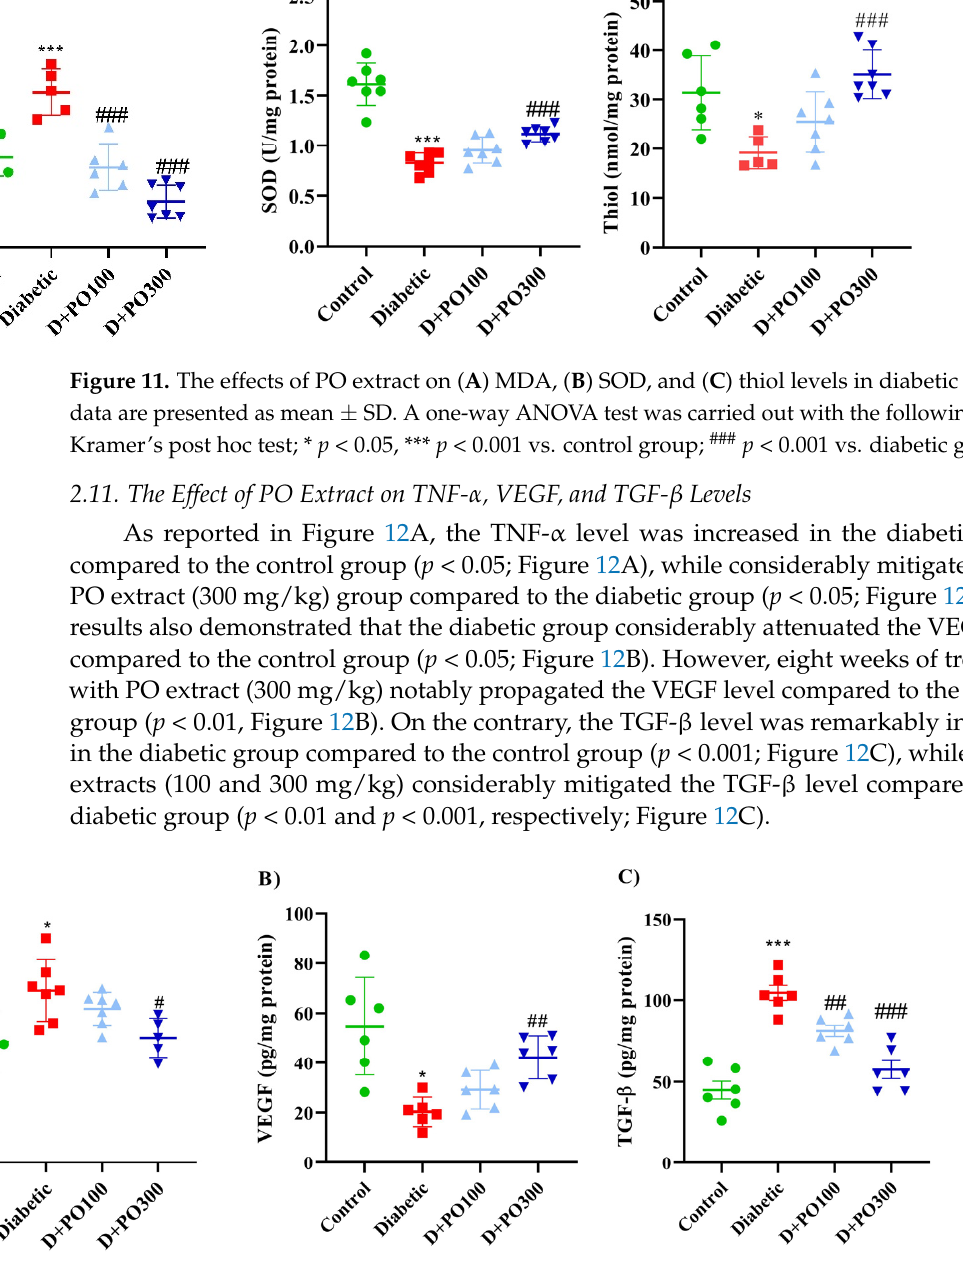
Figure 12. The effects of PO extract on the levels of ( A ) TNF- α , ( B ) VEGF, and ( C ) TGF- β levels in diabetic rats. The data are presented as mean ± SD. A one-way ANOVA test was carried out with the following Tukey–Kramer’s post hoc test; * p < 0.05, *** p < 0.001 vs. control group; # p < 0.05, ## p < 0.01, ### p < 0.001 vs. diabetic group.